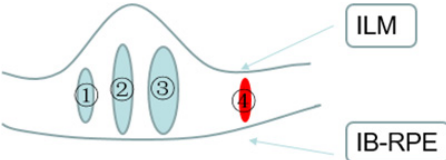
Fig. 5. A cartoon of intraretinal cysts. The three green items are real cysts, and the red one is a shadow.